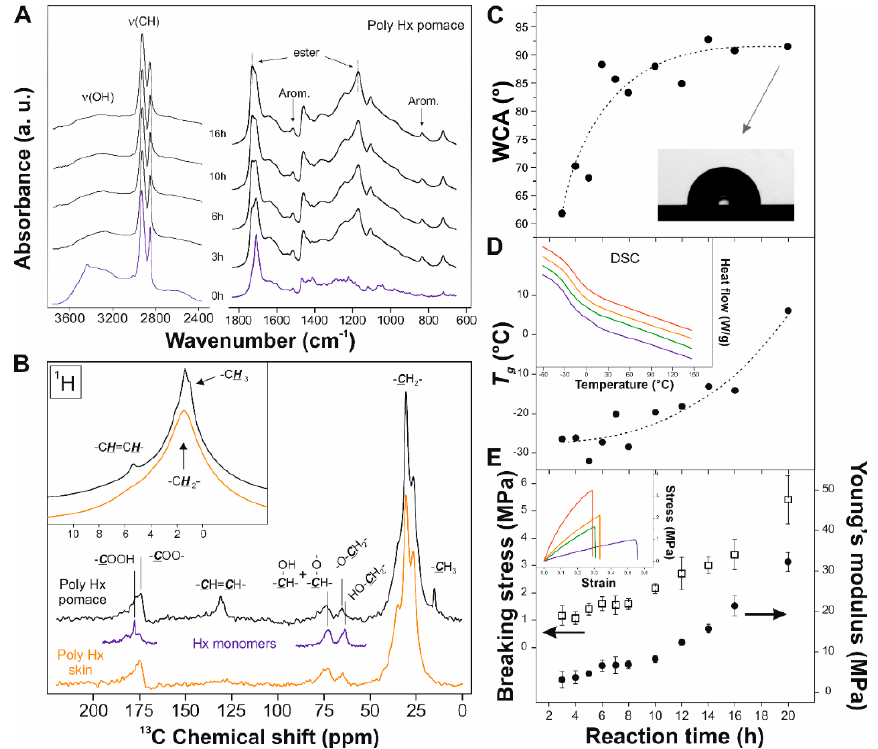
Figure 3. ( A ) ATR-FTIR spectra of polymer films obtained from Hx pomace (poly Hx pomace) at 150 °C in air at the indicated reaction time. ( B ) Solid-state NMR spectra of polymers obtained from Hx pomace (black) and Hx skin (orange). The regions ascribed to –COOH, –CH–OH, –CH–O–, –CH 2 –OH, and –CH 2 –O– of Hx monomers (blue) are also included. ( C – E ) Evolution of the water contact angle, glass transition temperature, and tensile parameters, respectively, with the reaction time of the synthesis of poly Hx pomace in air. Inset in C shows a typical drop on a surface of poly Hx pomace after 20 h of reaction. DSC (inset of D ) and stress-strain (inset of E ) curves correspond to polymers obtained after: (blue) 3 h, (green) 6 h, (orange) 10 h, and (red) 16 h reaction.